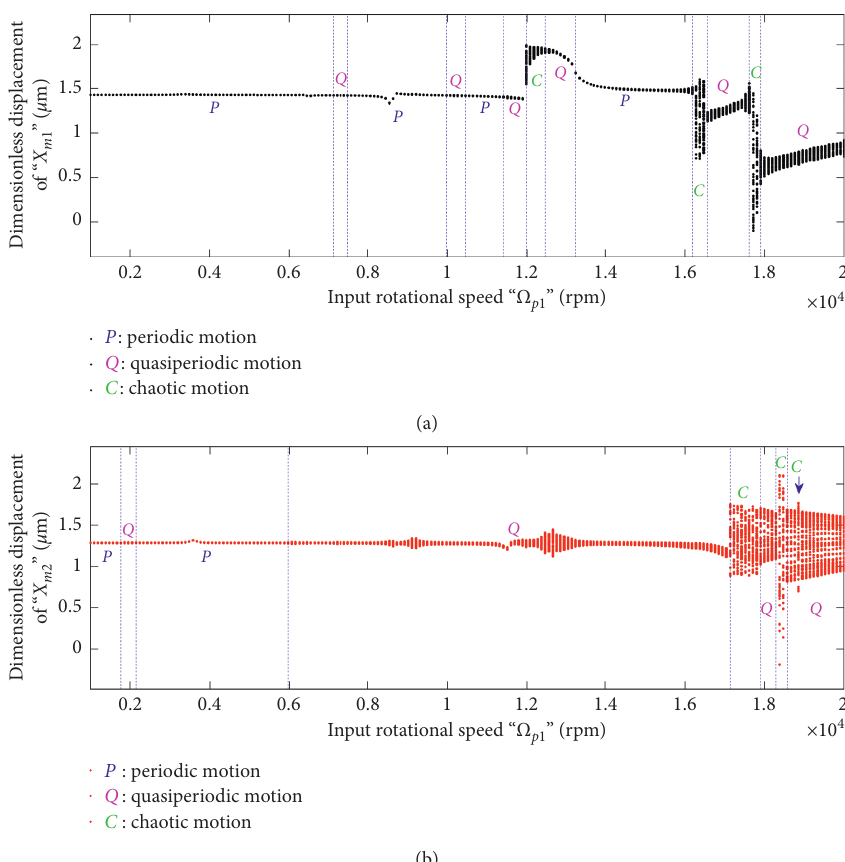
Figure 16: Backward bifurcation diagrams of system; s